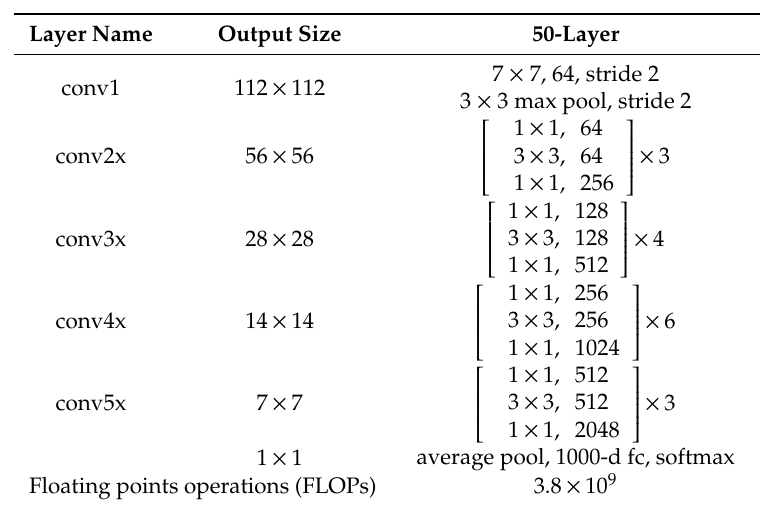
Table 11. ResNet50 network